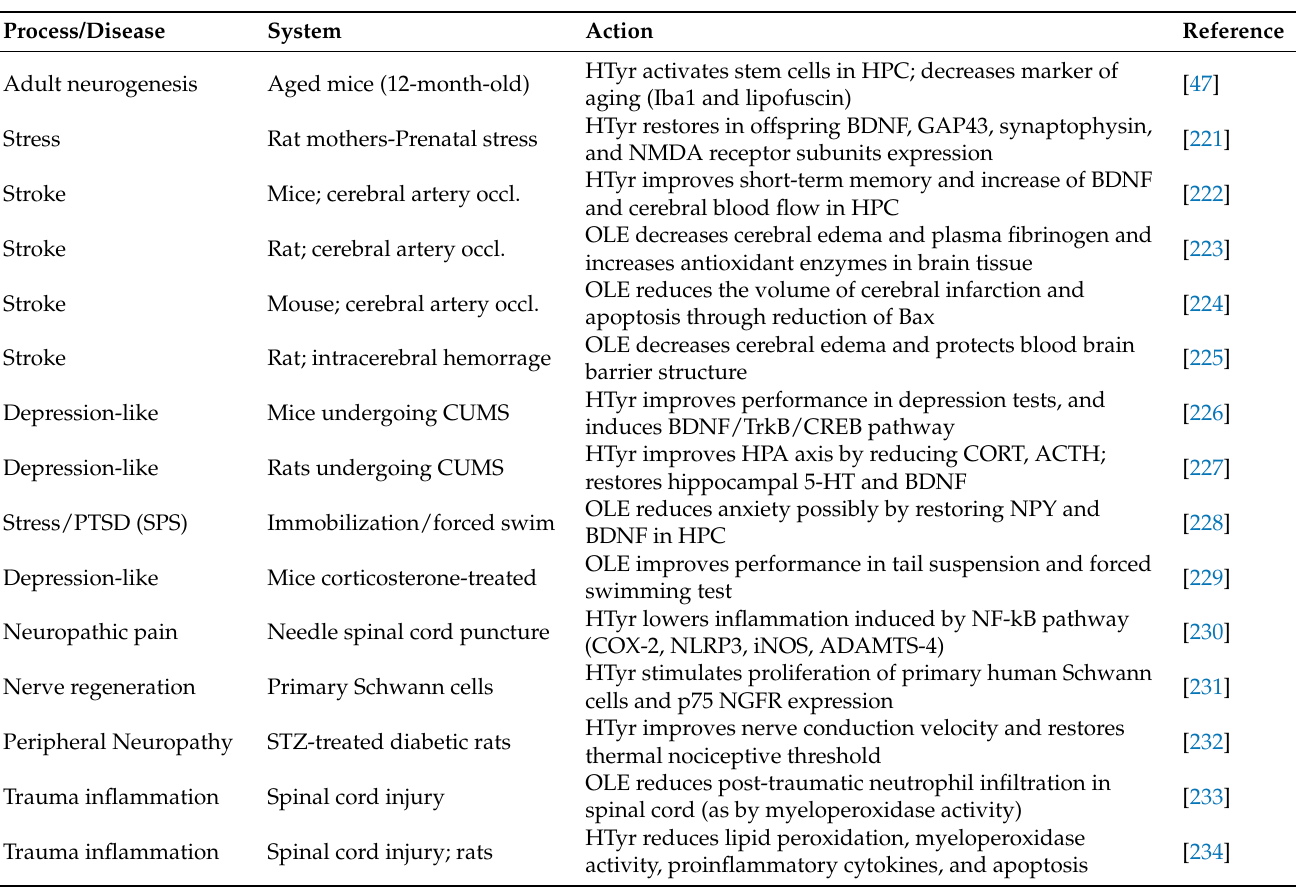
Table 2. Effects of HTyr or of OLE on stroke, adult neurogenesis, age-associated stress and depression, and peripheral nervous